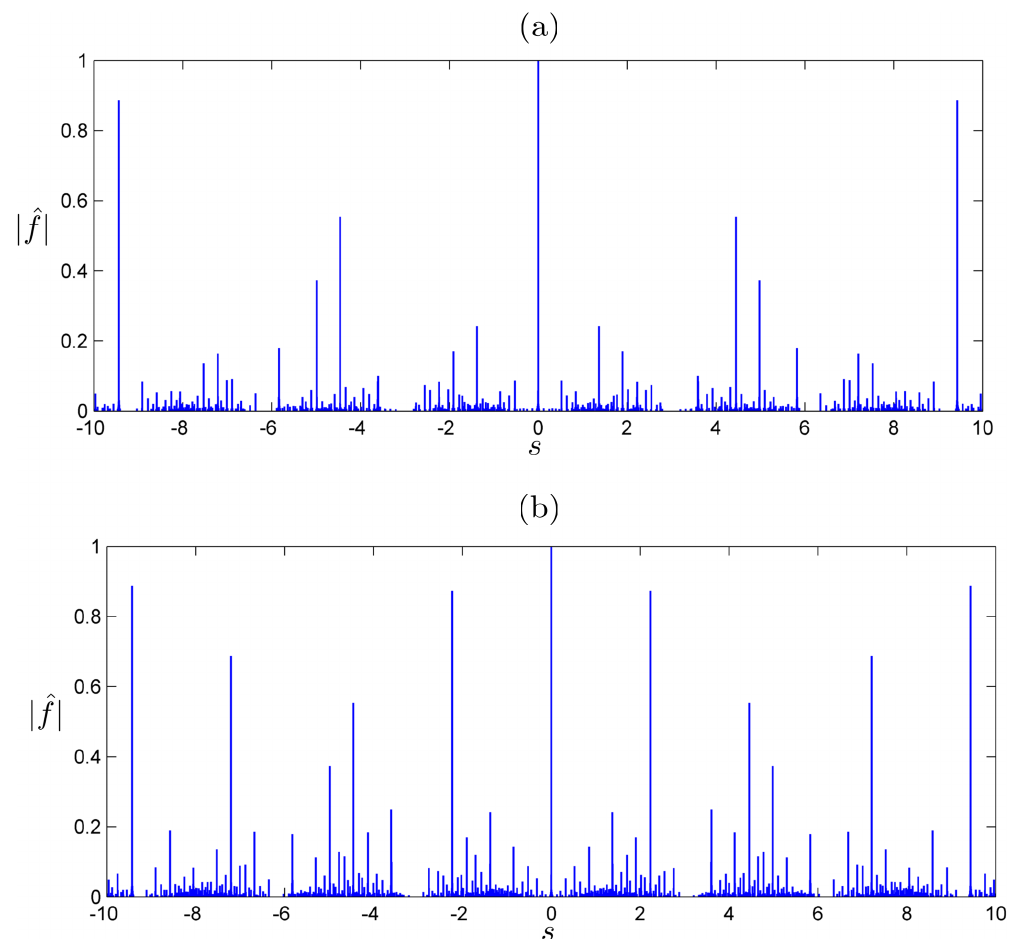
Figure 6. Normalized FT (magnitude) of a Fibonacci lattice with 2585 points. The reciprocal space s region 10 10 has been sampled at 10,001 points in ( a ) and at 20,001 points in ( b − ≤ ≤